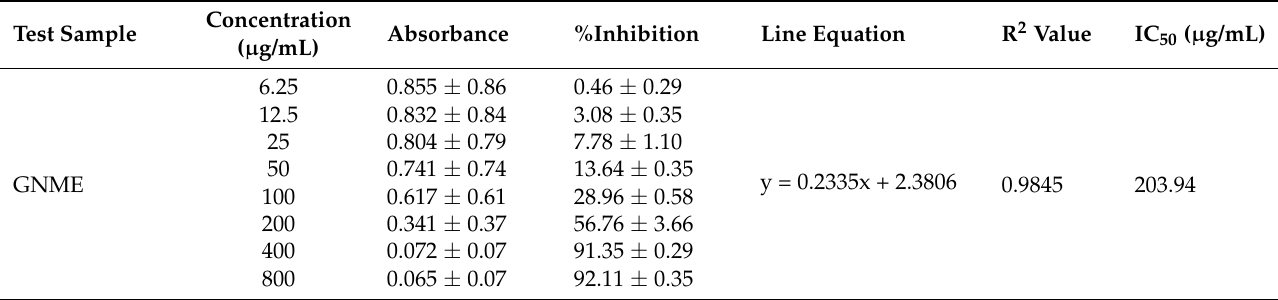
Table 5. Activity of GNME in DPPH scavenging